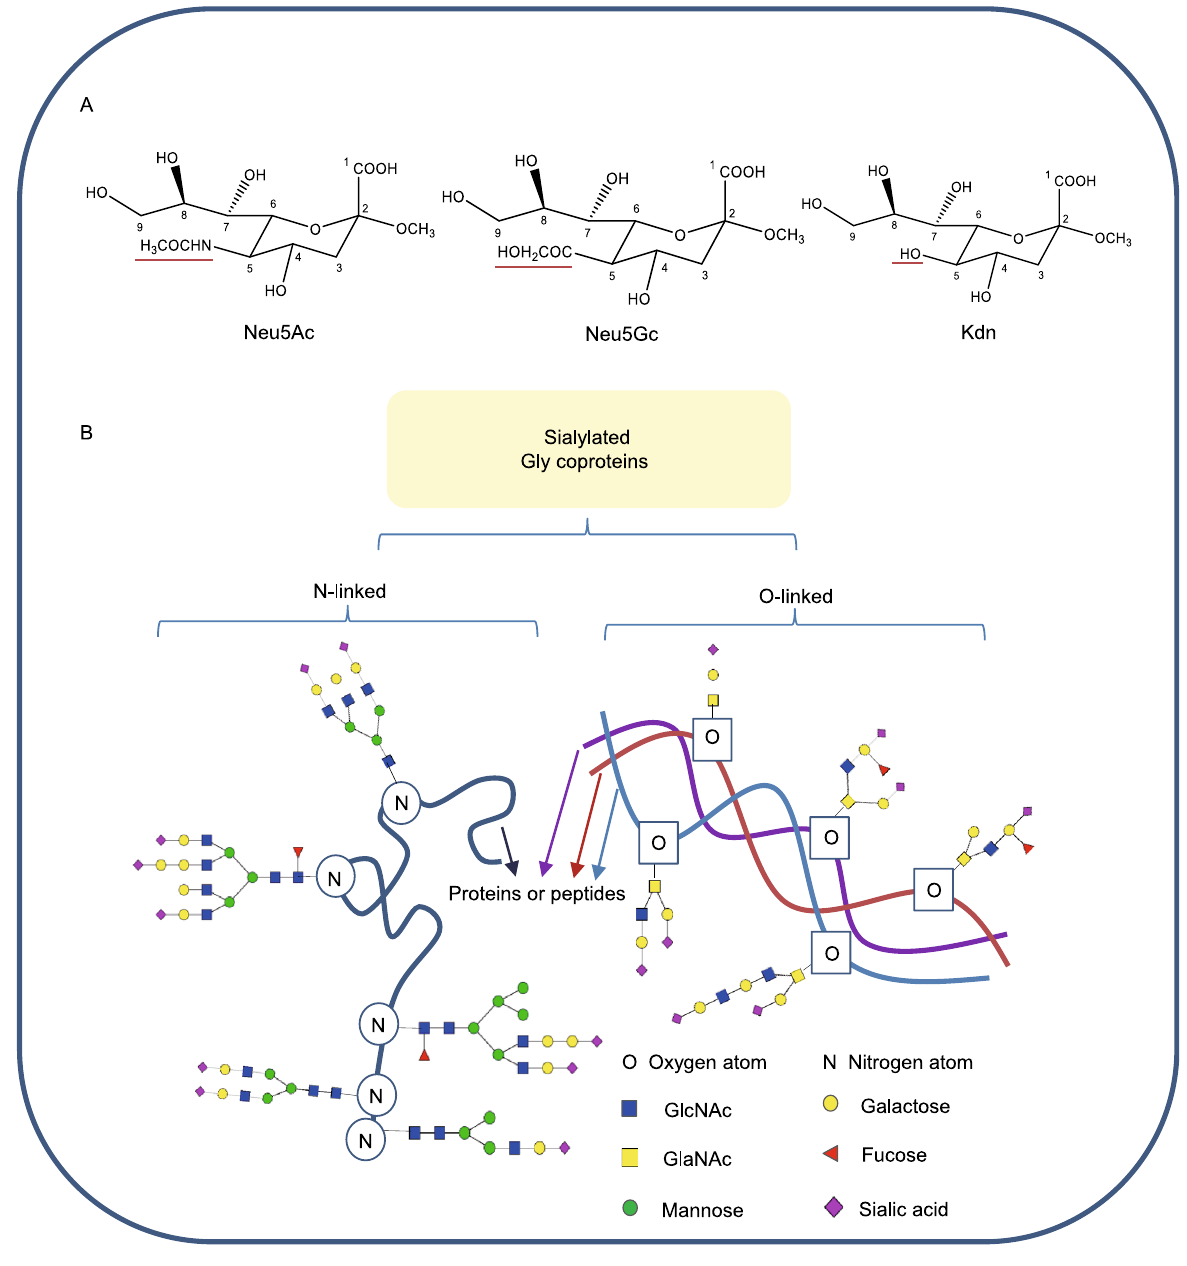
Figure 1. Structures of sialic acids and the diversity of sialylated glycoproteins. (A) Structures of sialic acids. Neu5Ac, Neu5Gc and Kdn are similarly structured and they possess different groups at the C5 position, which are red underlined. (B) The diversity of sialylated glycoproteins. Sialylated glycans can be attached to proteins or peptides through oxygen atom on serine/threonine or nitrogen atom on asparagine. And sialylated glycans can be linear or branched, comprised of multiple saccharides, including GlcNAc, GalNAc, mannose, fucose, galactose and so